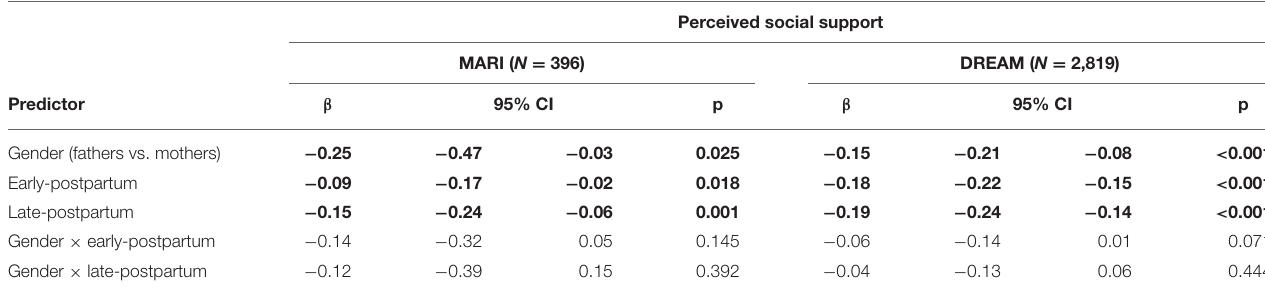
TABLE 5 | Peripartum (changes in) perceived social support, including differences between (expectant) mothers and fathers, in MARI ( N = 396) and DREAM ( N =